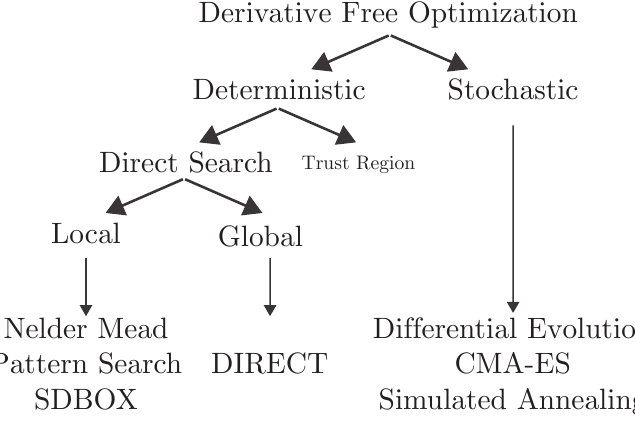
Figure 2. Categories of the optimization